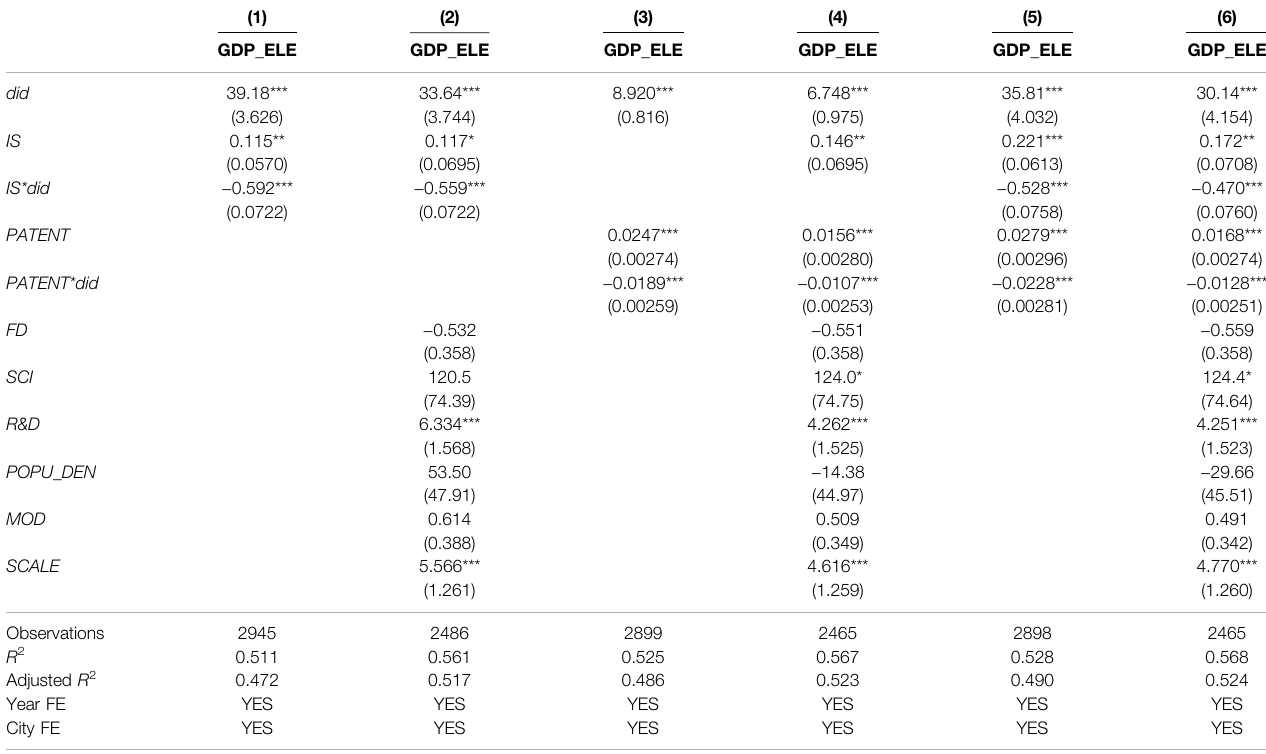
TABLE 8 | Results of the mediation effect